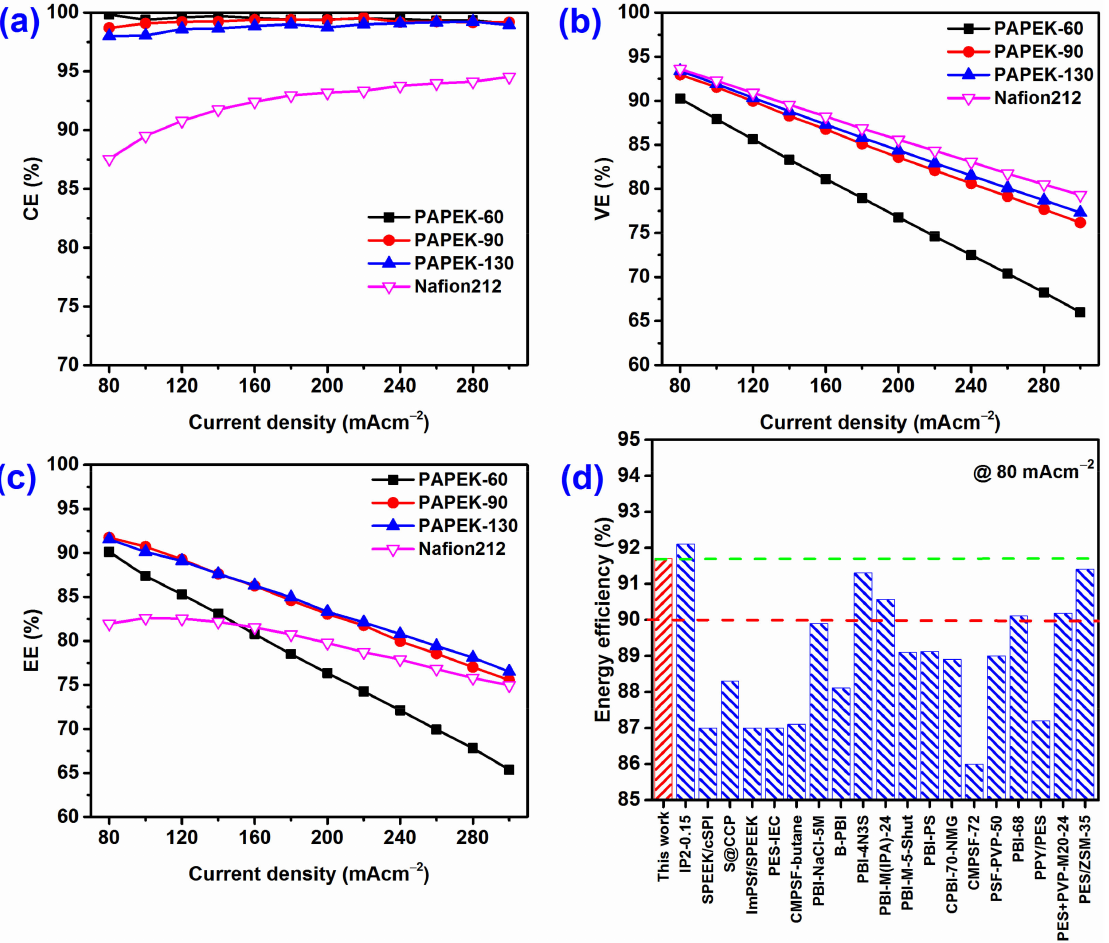
Figure 6. Battery performance of VFB with PAPEK and Nafion 212 membranes. Coulombic efficiency ( a ), voltage efficiency ( b ), energy efficiency ( c ), and energy efficiency ( d ) of PAPEK and other reported